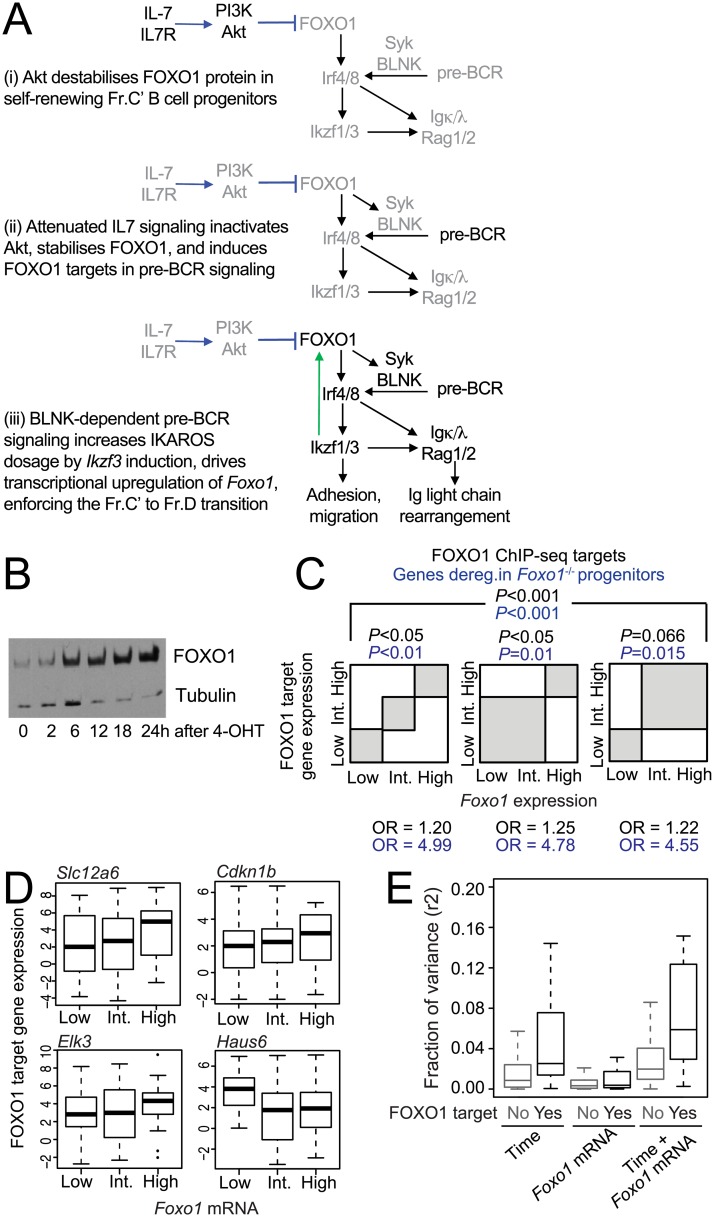
Transcriptional regulation of FOXO1 target genes.(A) Scheme of post-translational (i and ii) and transcriptional (iii) regulation of Foxo1 during B cell progenitor differentiation. (B) Western blotting for FOXO1 protein expression during the Fr.C to Fr.D transition. (C) Analysis of scRNA-seq time series data for a correlation between Foxo1 mRNA level and the expression of FOXO1 target genes. FOXO1 target genes were defined by ChIP-seq peaks in promoters as described above (black ORs and P values). Alternatively, FOXO1 target genes were defined based on the deregulation of genes after genetic deletion of Foxo1 in early lymphoid/B cell progenitor cells ([40] blue ORs and P values). B3 cells with low, medium, and high Foxo1 mRNA level were analyzed separately (left), cells with low and medium Foxo1 mRNA level were pooled (middle), or cells with medium and high Foxo1 mRNA level were pooled (right). Genes were defined as significantly associated with Foxo1 if P < 0.01 (Fisher test). We conducted an enrichment analysis comparing targets and nontargets. P values and ORs are shown. (D) Examples for the relationship between Foxo1 mRNA and mRNA expression of selected FOXO1 targets in scRNA-seq time series data. The source of the numerical data underlying this figure is listed in S1 Data. (E) The bars indicate the amount of variance (r2 values calculated based on the difference between linear models) of FOXO1 target gene expression [40] after Ikaros induction by 4-OHT treatment is accounted for by time, Foxo1 mRNA expression, and the combination of time and Foxo1 mRNA expression in scRNA-seq. The source of the numerical data underlying this figure is listed in S1 Data. ChIP-seq, chromatin immunoprecipitation sequencing; FOXO1, Forkhead Box O1; Fr.C, proliferating B cell progenitor; Fr.D, differentiating B cell progenitor; OR, odds ratio; scRNA-seq, single cell RNA sequencing; 4-OHT, 4-hydroxy-tamoxifen.